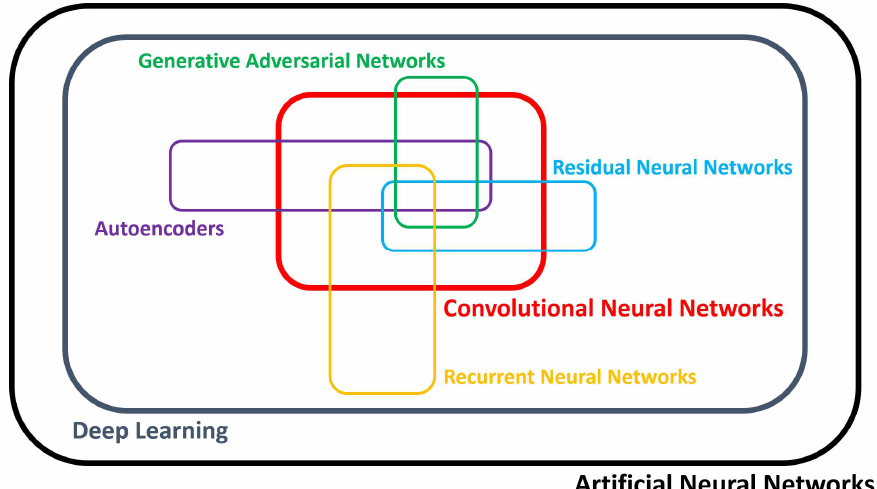
Figure 2 . ANN Venn diagram. This image shows that under the big ANN umbrella, CNNs, GANs, ResNets, autoencoders, and RNNs are typical deep learning models. Although they are all inde- pendent network architectures, it is very common to combine some of them together in real appli- cations.